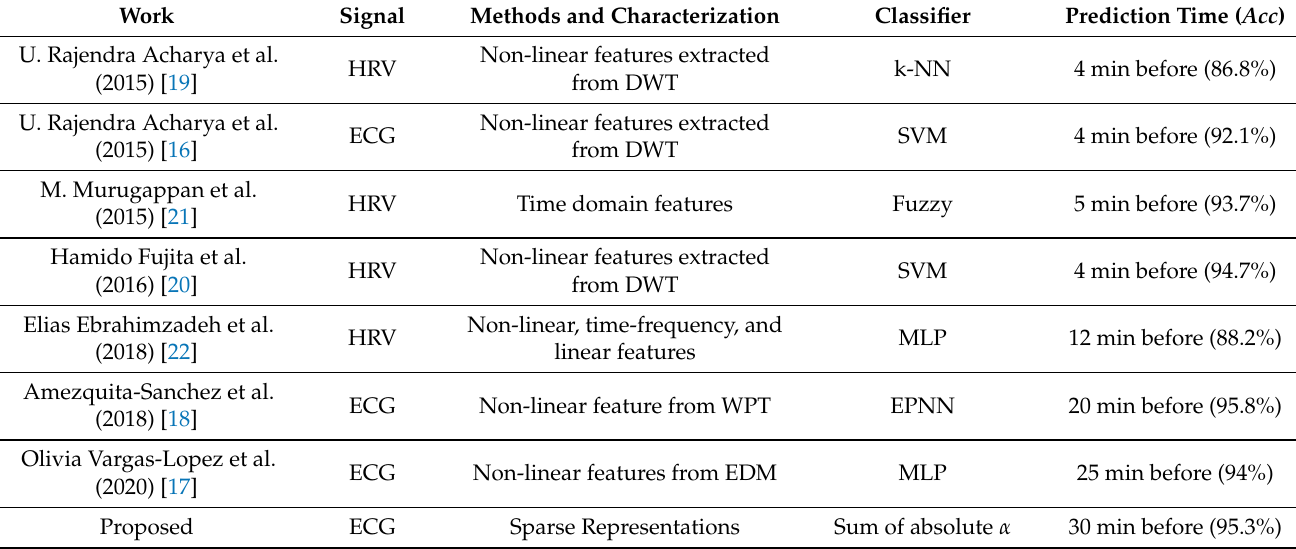
Table 4. Prediction and accuracy comparison. The MIT/BIH NSR and MIT/BIH SCDH databases were used in all cases.